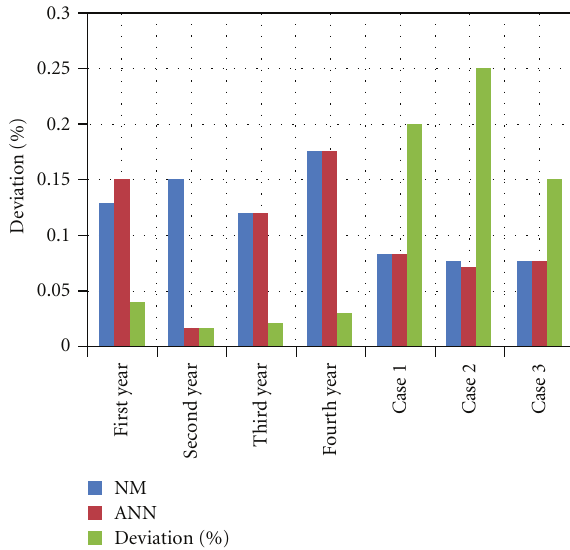
Figure 2: SAIFI values feeder X14 with deviation less than 0.25.